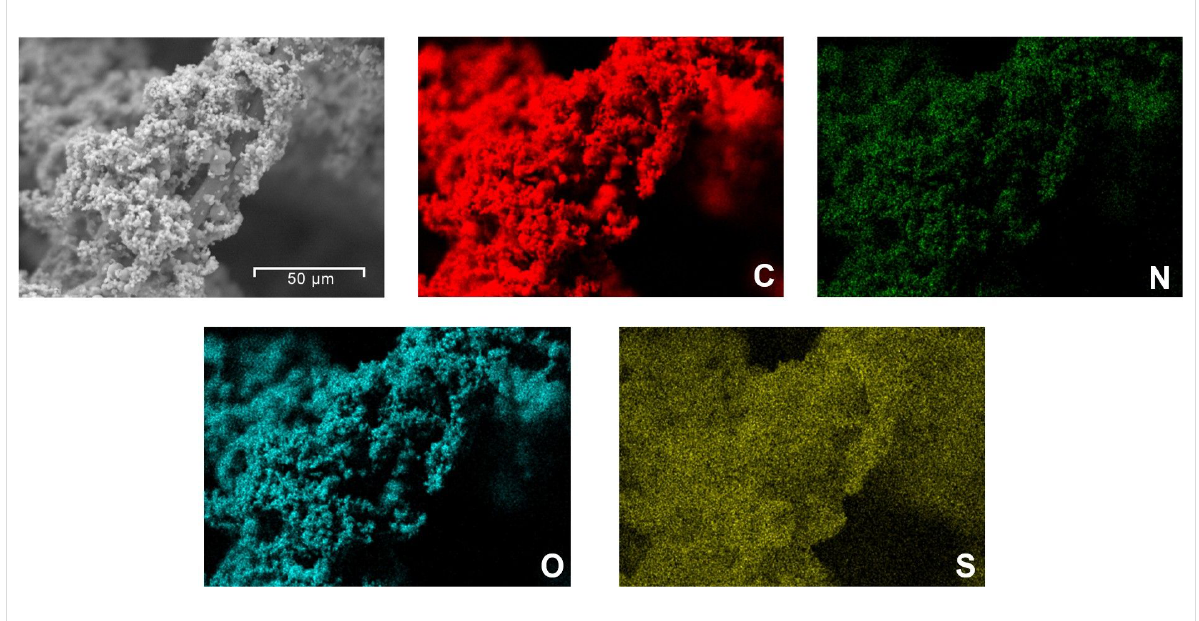
Figure 3: SEM image of the co-doped composite electrode and corresponding colored mappings of carbon, nitrogen, oxygen and sulfur.